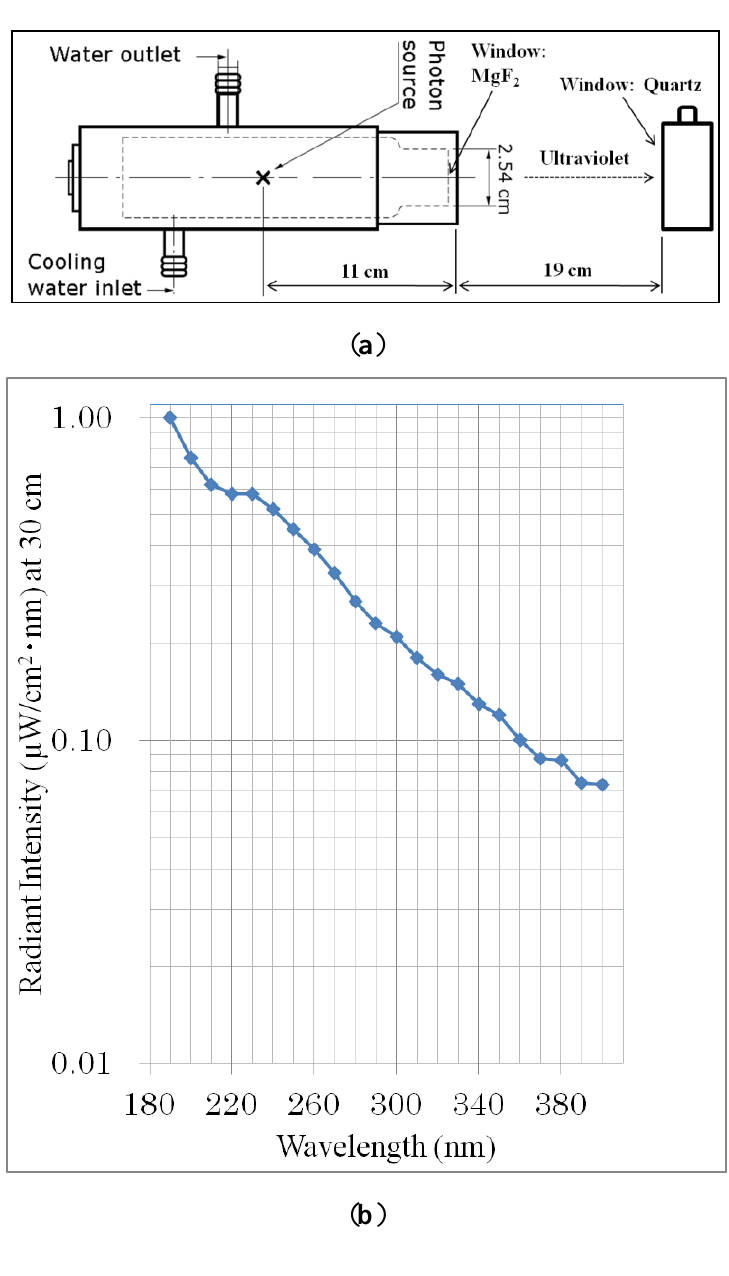
Figure 6. ( a ) Schematic diagram of the experimental setup for UV irradiation (continuous, 190–400 nm) from a deuterium lamp (L1835; HAMAMATSU Photonics). ( b ) Typical spectral irradiance of the deuterium lamp was measured by